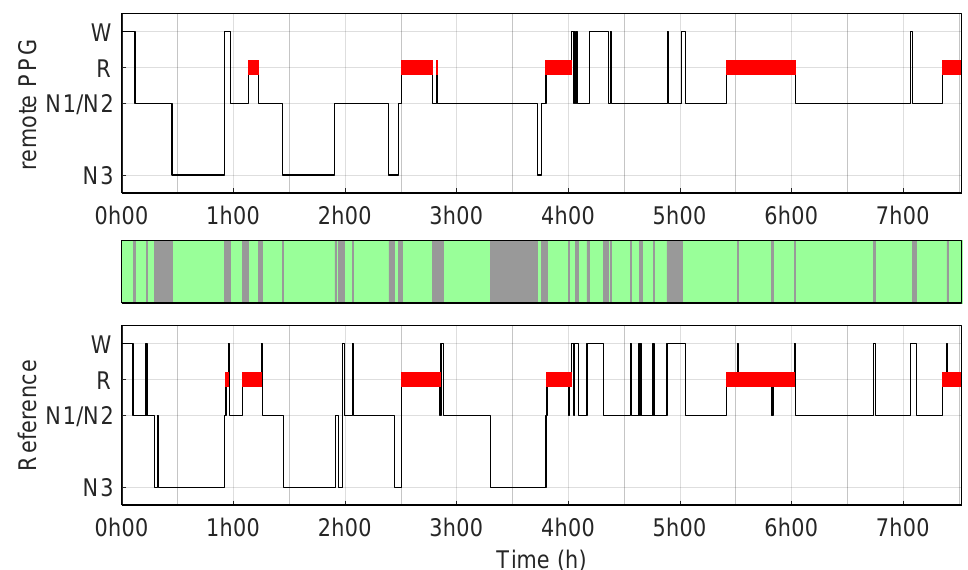
Figure 2. Hypnogram for the highest performance of remote PPG setup. Hypnograms for one example recording of a participant for which the predictions of the remote PPG setup compared to PSG manual scoring has the highest κ remotePPG value (accuracy 82%, κ = 0.71); ( top ) hypnogram predictions using remote PPG; ( bottom ) reference hypnogram based on PSG manual scoring. The coloured bar in between illustrate the correspondence with the reference hypnogram, with green indicating that the prediction of each setup matches the reference, and grey indicating a mismatch for that epoch.